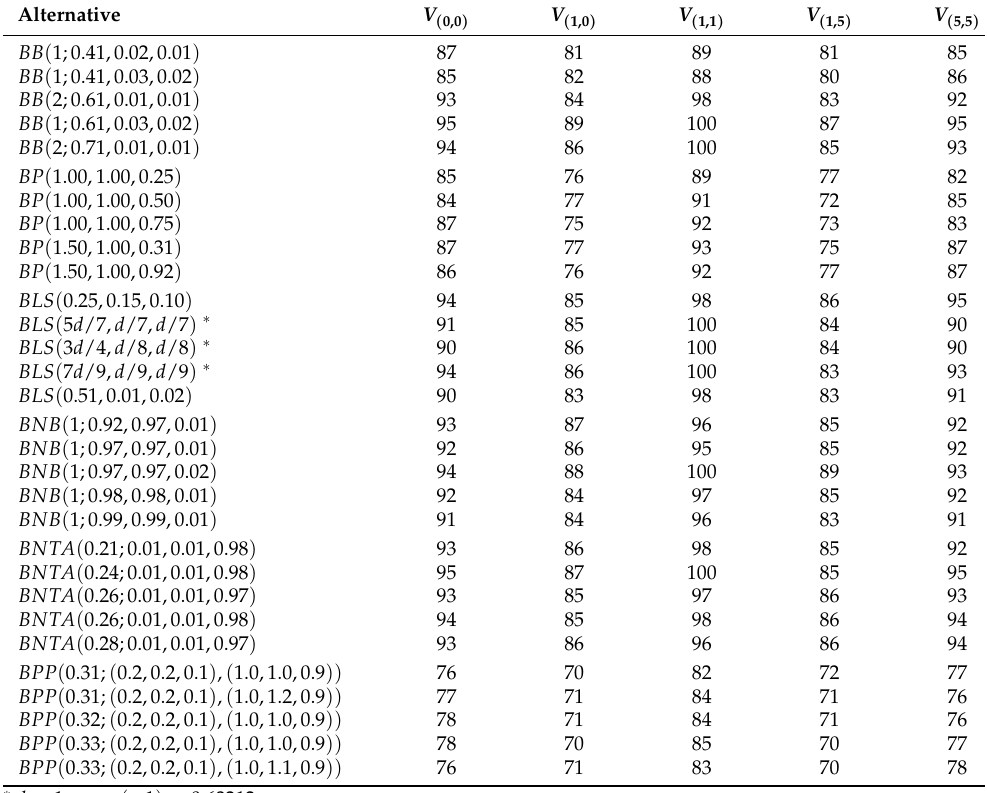
Table 8. Simulation results for the power. The values are in the form of percentages, rounded to the nearest